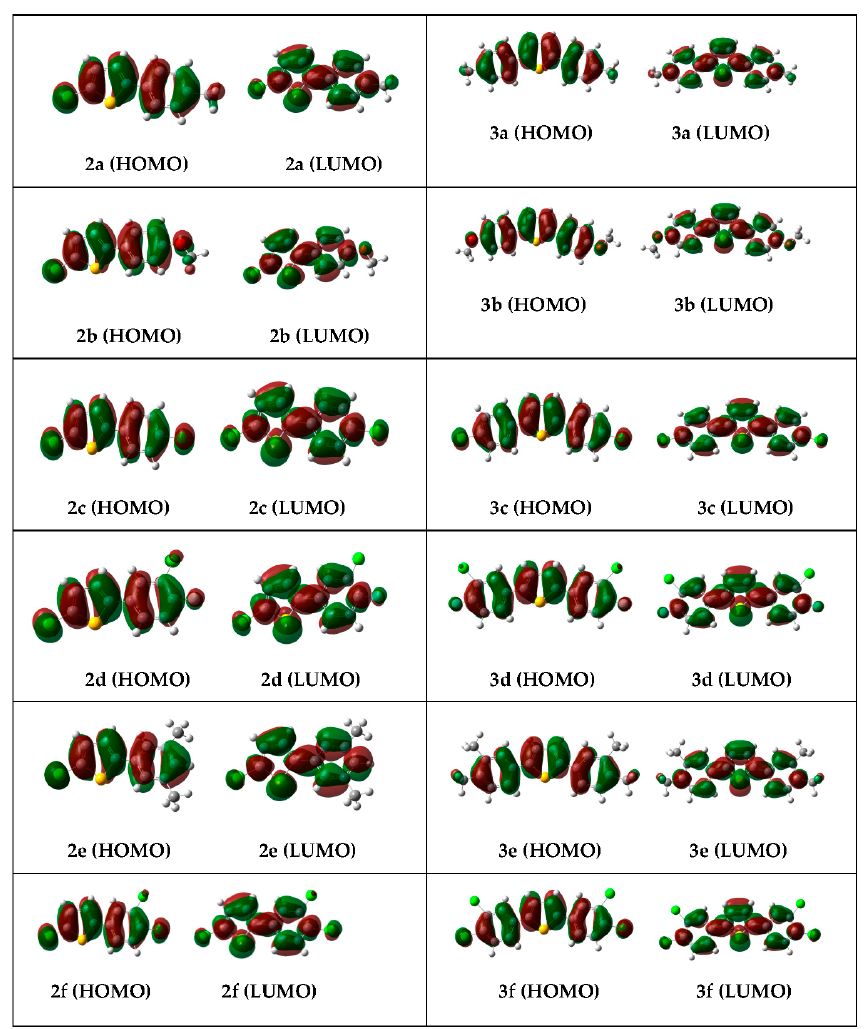
Figure 6. HO/LU orbitals of 2a – f and 3a – f .